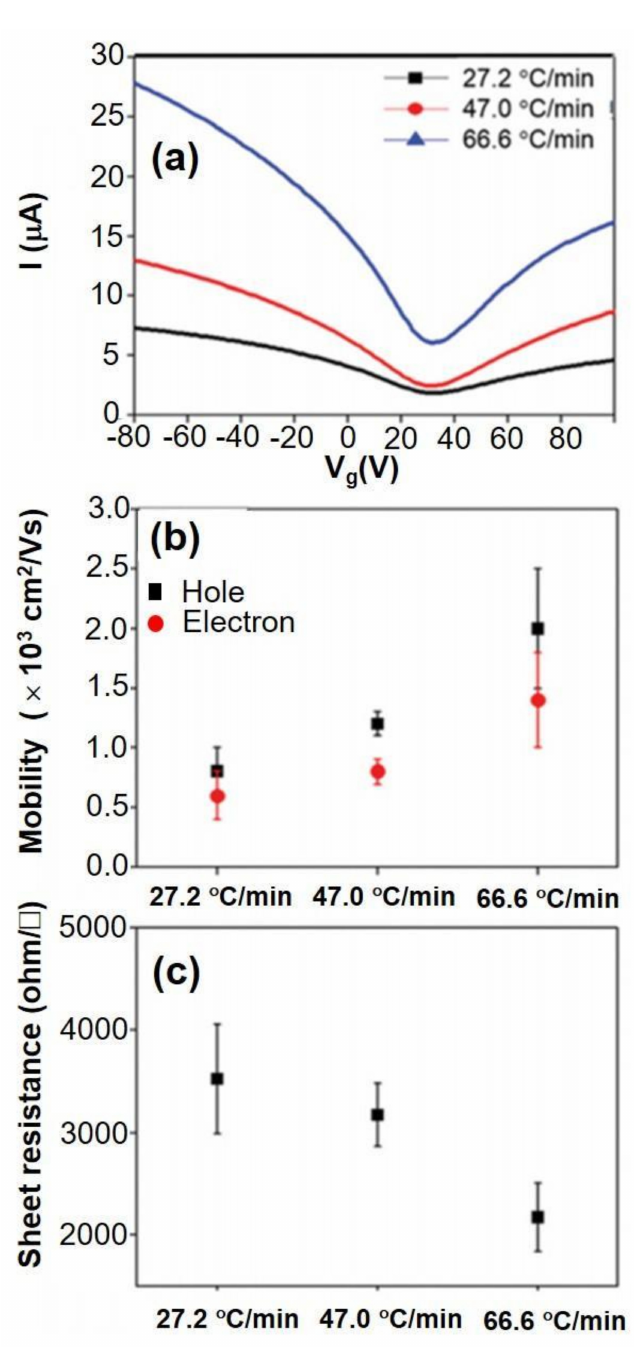
Figure 16. ( a ) Transferred I/V characteristic curves, ( b ) Carrier mobility and ( c ) Sheet resistance profile, at individual cooling rate. Reprinted with permission from ref.